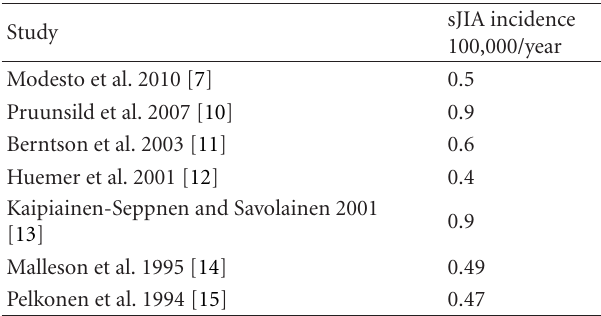
Table 1: Incidence of sJIA (per 100,000/year) in the